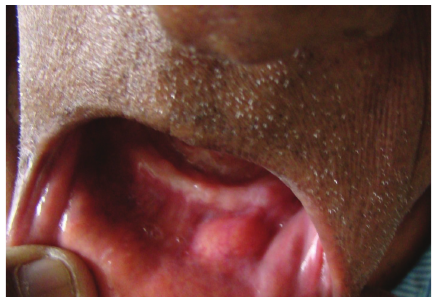
Figure 3: Excised specimen.